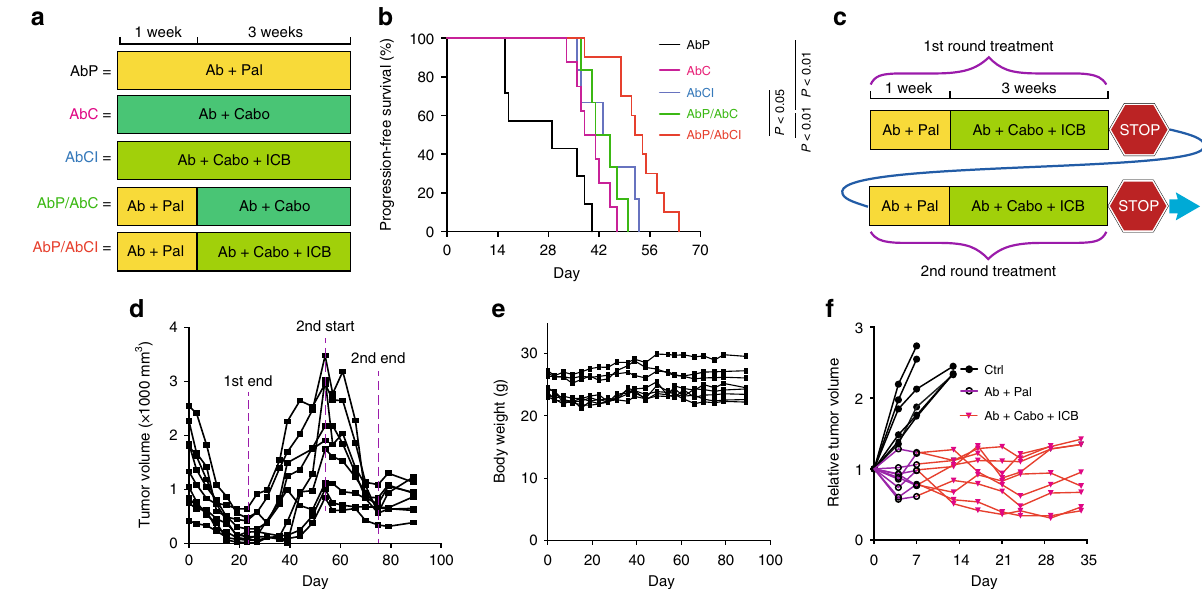
Fig. 5 Sustained response to sequential combinatorial immunotherapy in rapidly evolving Her2-positive breast cancer. a Short-term experimental design for testing ef fi cacy of indicated treatment schedule in MMTV-neu mice with spontaneous, advanced-stage tumors. b Kaplan – Meier progression free (without tumor volume increase) survival curves for different treatment and schedule as indicated in a ( n = 6 – 8). P -value by log-rank (Mantel – Cox) test. c